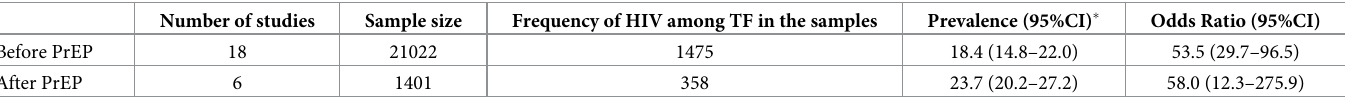
Table 6. HIV prevalence and odds ratios for trans feminine individuals compared to all adults (age 15+) in US-based studies, according to whether data was col- lected before or after the introduction of PrEP (2012). Number of